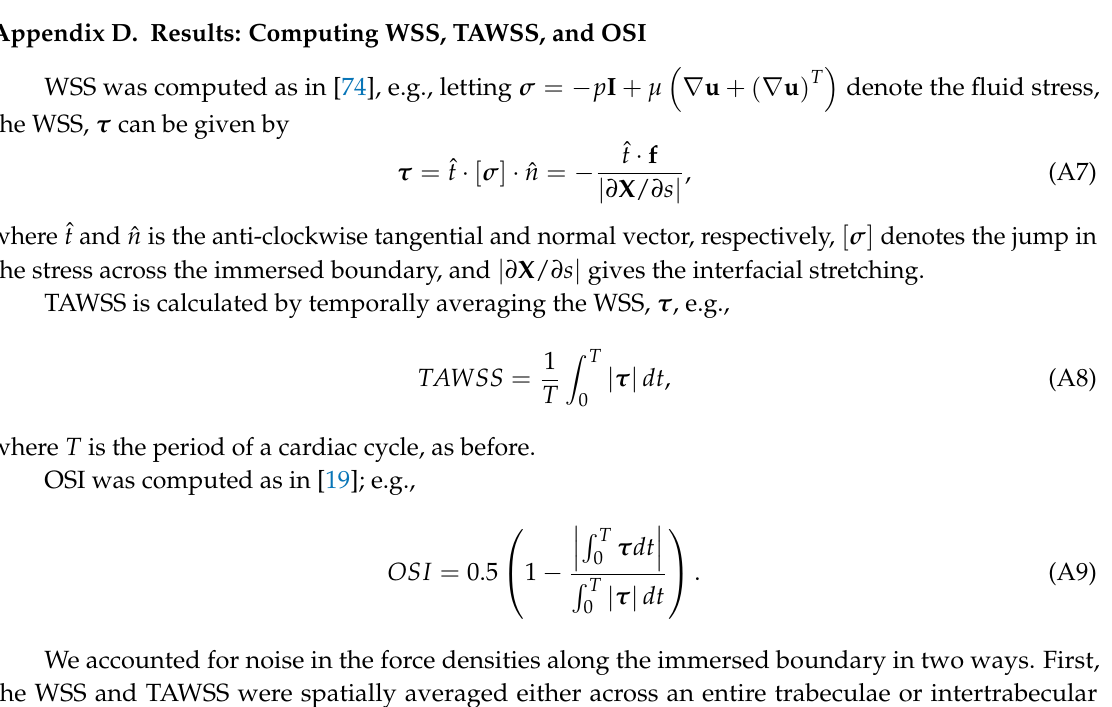
Figure A4. Plots showing how the magnitude of velocity decays from the center of the atrioventricular (AV) canal to the ventricle wall for five different lines across the chamber using the ErbB2 -inhibited emrbyo’s